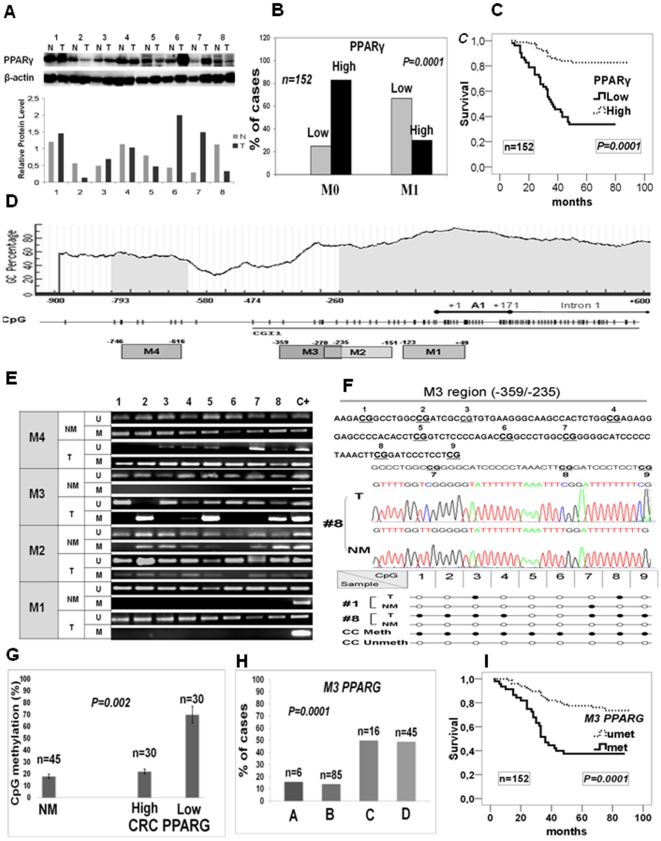
A specific PPARG promoter methylation is associated with protein expression and patients' poor prognosis.(A) Fifty µg of total protein extracts from tumour tissues (T) and matched non-neoplastic mucosa (N) were analyzed by Western blot. In the panel only some representative samples (from 1 to 8) are shown. The histogram reports the quantification to β-actin, used as internal control. (B) Correlation of PPARG expression levels in the absence = M0 or presence = M1 of distant metastases. (C) Kaplan Meier survival analysis related to PPARG expression levels. The P value is reported in each graph. (D) Schematic structure of the PPARG promoter and identification of the CpG-enriched regions encompassing the transcription start site of the human gene. The MS-PCR regions analyzed (M1–M4) and the positions of the primers used are depicted as rectangles. (E) Representative MS-PCRs show a correlation between methylation of the M3 region and reduced PPARG expression in tumour tissues vs. matched normal mucosa, C+ indicates methylated (M) and unmethylated (U) controls. (F) The M3 nucleotide sequence is reported; the CpG islands are highlighted. The chromatograms show which CpG dinucleotide is methylated in some representative samples after BS. Black or white circles indicate the methylated or unmethylated cytosines, respectively. (G) Methylation levels detected by BS in tumour and normal mucosa specimens. The M3 region methylation is related to tumour' stage (Duke's from A to D) (H) and patients' survival (I). The P value is reported in each graph.